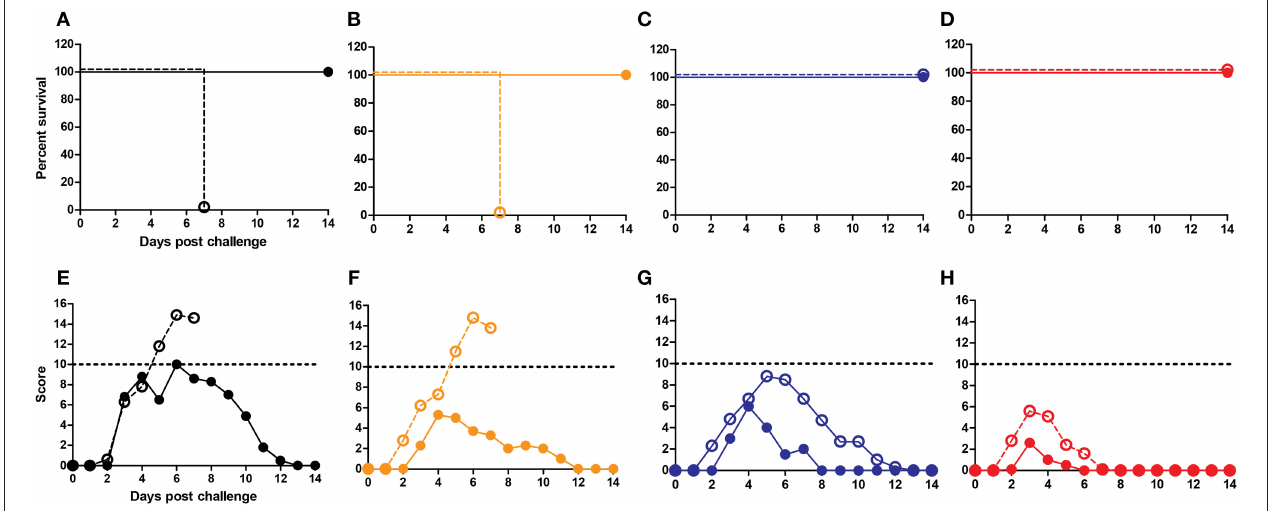
FIGURE 5 | IgA antibodies are not critical in cross-protection. IgA KO mice and BALB/c mice were vaccinated thrice i.n. with PBS (A,E) , non-adjuvanted WIV (B,F) , WIV + CAF-09 (C,G) or WIV + CTA1-3M2e-DD (D, H) followed by heterosubtypic challenge. The mice were followed for survival (A–D) and development of clinical symptoms (E–H) for a period of 14 days. IgA KO mice are represented by dashed lines with open symbols while BALB/c wt mice are represented by solid lines with filled symbols. Dotted lines indicate humane